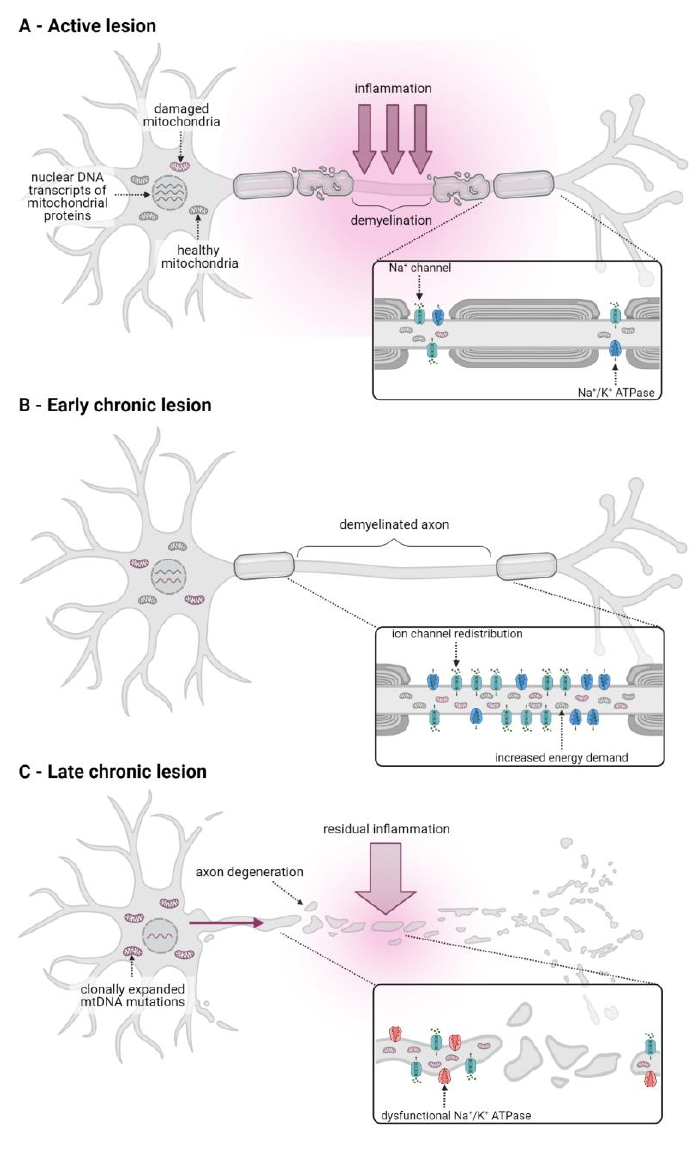
Figure 2. Mitochondrial dysfunction contributes to CNS pathology in all stages of MS. ( A ) In active white matter lesions of acute MS, inflammatory mediators released by activated immune cells induce mitochondrial dysfunction and contributes to axonal demyelination. ( B ) The redistribution of sodium channels in demyelinated axons in chronic inactive lesions of progressive MS patients results in an increased energy demand due to an upregulation of sodium/potassium (Na + /K + ) ATPase activity. A subsequent increase in mitochondrial number and activity protects the demyelinated axon against energy deficiency-induced degeneration. ( C ) Over time, mitochondrial damage in the axon accumulates, both due to increased ROS production by damaged mitochondria and residual inflammation in the vicinity of the axon and due to the supply of dysfunctional mitochondria from the soma (pink arrow) that is caused by reductions in nuclear DNA transcripts of mitochondrial proteins and clonal expansion of mtDNA mutations. This results in axonal energy deficiency, Na + /K + ATPase failure, and subsequent intra-axonal ionic imbalances that trigger degenerative